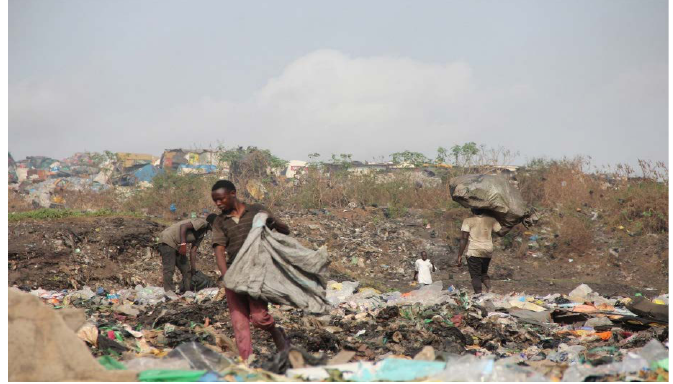
Figure 3. Cross-section of a vast open dump at Ado-Odo Local Government.